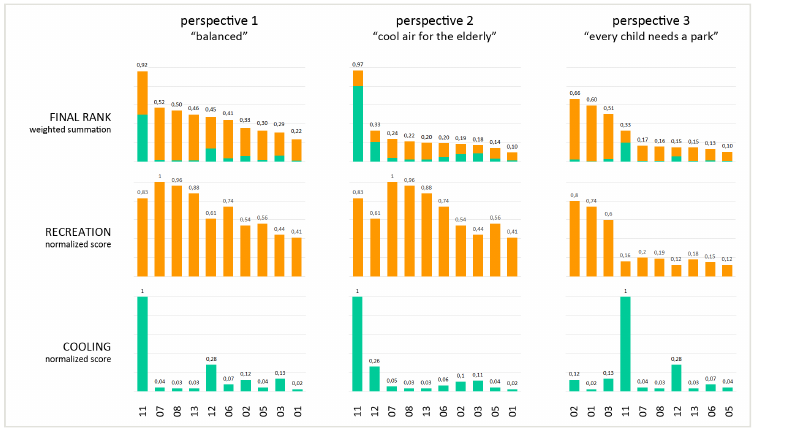
Figure 8. Final rankings of the regeneration scenarios according to three perspectives considered in the multi-criteria analysis. The weights assigned to the di ff erent ES and the di ff erent categories of bene fi ciaries are reported in Table 1. Scenarios 04, 09and 10 were identi fi ed as sub-optimal alternatives and excluded from the multi-criteria analysis.